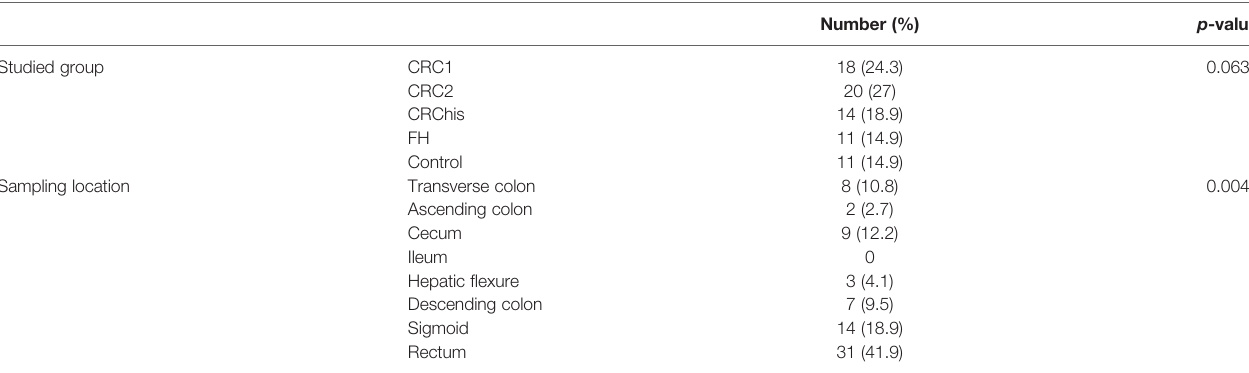
TABLE 2 | Prevalence of the Escherichia coli isolates.